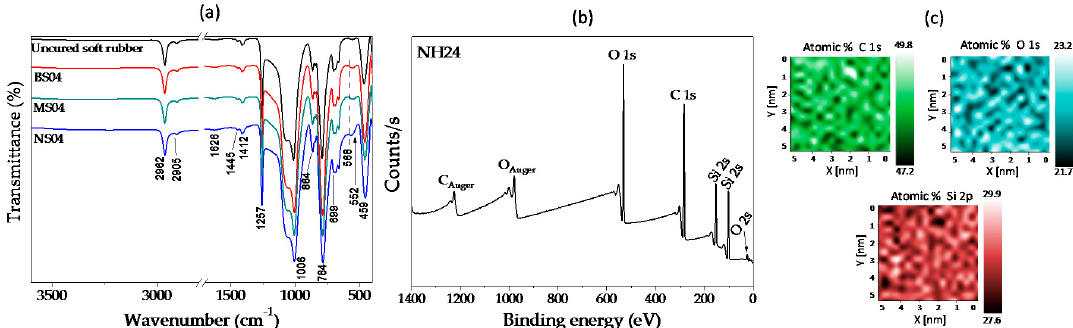
Figure 13. ( a ) FTIR spectra of samples manufactured using a soft matrix with 4% of SO; ( b ) X-ray photoelectronic spectroscopy (XPS) of NH24 sample showing the presence of carbon (C), oxygen (O) and silicon (Si) elements; ( c ) XPS mapping with the elemental composition.